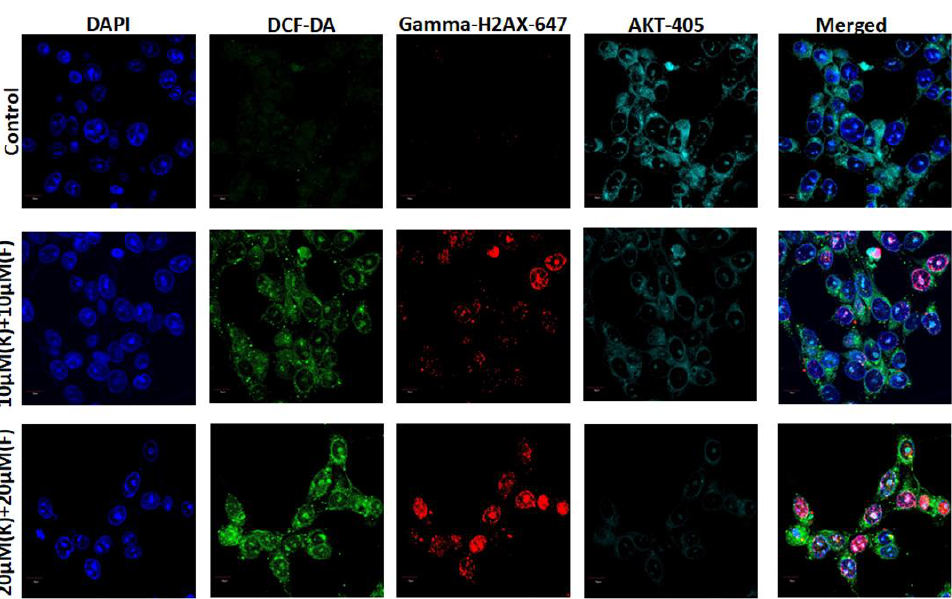
Figure 5. ROS, γ-H2AX, and Akt expressed after treatment with 10 and 20 μM (K + F) against MDA- MB-231 cells after 24 h by confocal microscopy; DAPI was used as a nuclear stain.